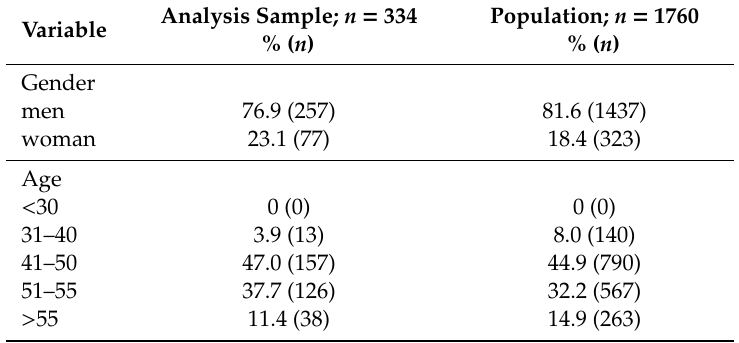
Table 3. Comparison analysis sample to population of upper-level managers in